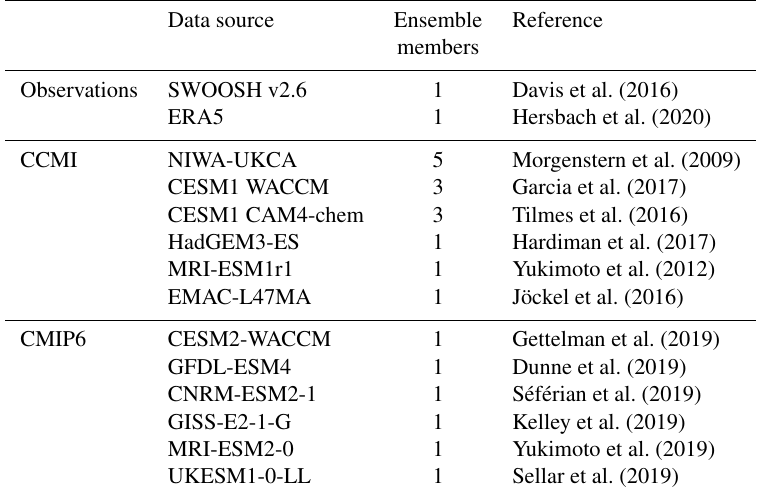
Table 1. The data sources used in this study. For CMIP6 models, we focus on the historical integrations of the period from 1850 to 2014; for CCMI, we focused on the Ref-C2 simulations spanning the period from 1960 to 2100.